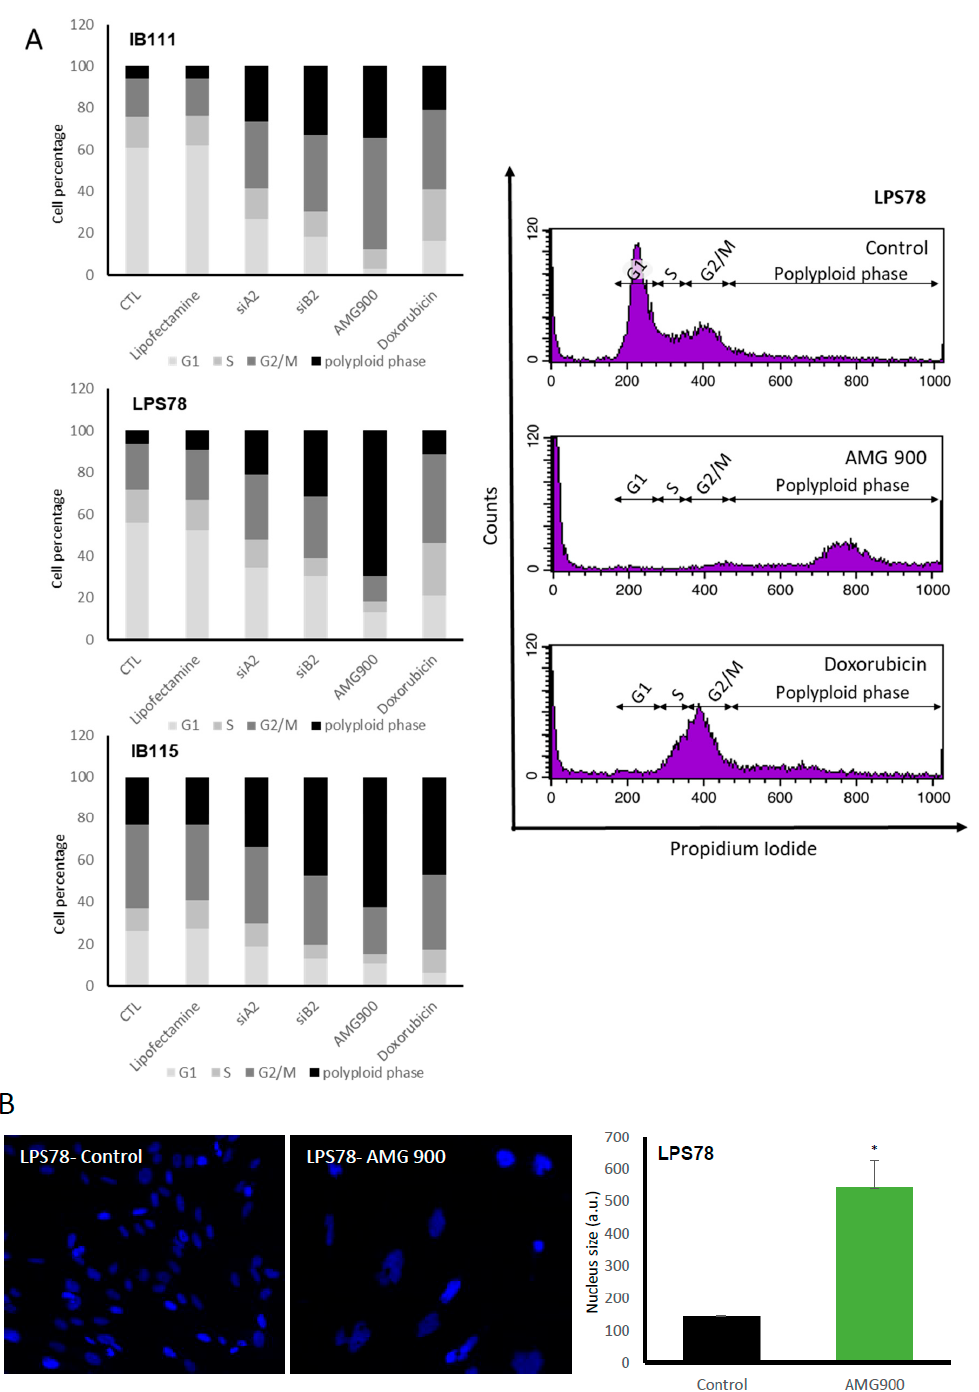
Figure 6. Modulation of AURKA and AURKB regulates cell cycle phases and leads to polyploidy. ( A ) Modification of cell cycle upon treatment in three LPS cell lines. Flow cytometry analyses are done on cells lines probed by PI, 72 h post-treatment: siRNA transfection, AMG 900 or doxorubicin. All the cell cycle phases for one condition are represented in vertical. ( B ) LPS78 nucleus aspect after 72H post-AMG 900 treatment. Nucleus were labelled with Hoechst 33342. Experiments were done in triplicate, with at least 100 events are analysed by experiment. Magnification ×400. (*: p < 0.05).